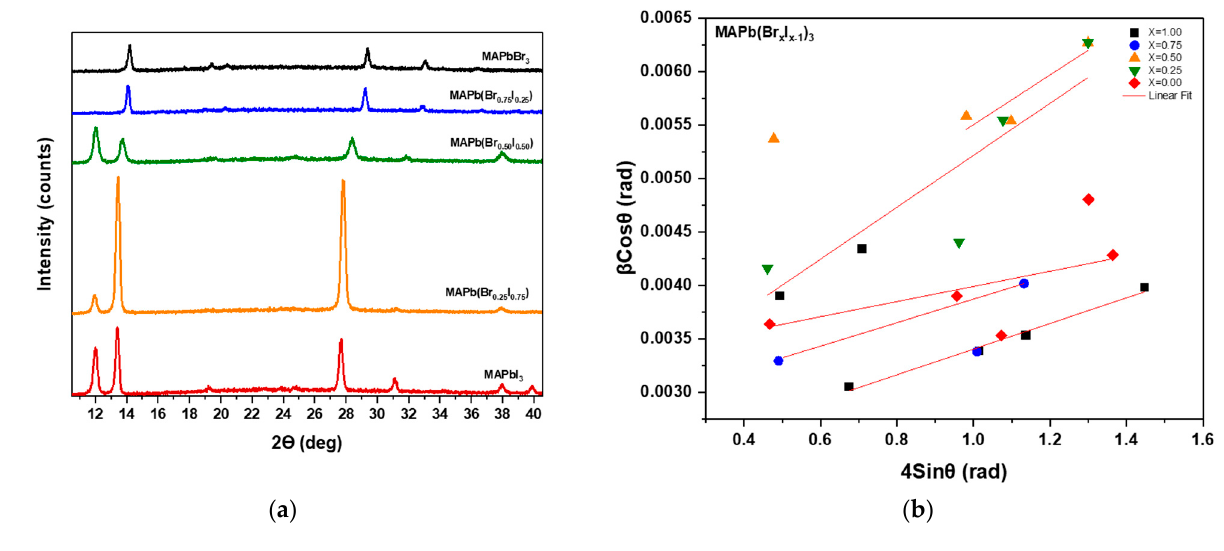
Figure 4. ( a ) XRD pattern and ( b ) W-H plot, of the MAPb ( Br x I 1-x ) 3 thin films. Table 1. Values for an XRD pattern at three peaks.